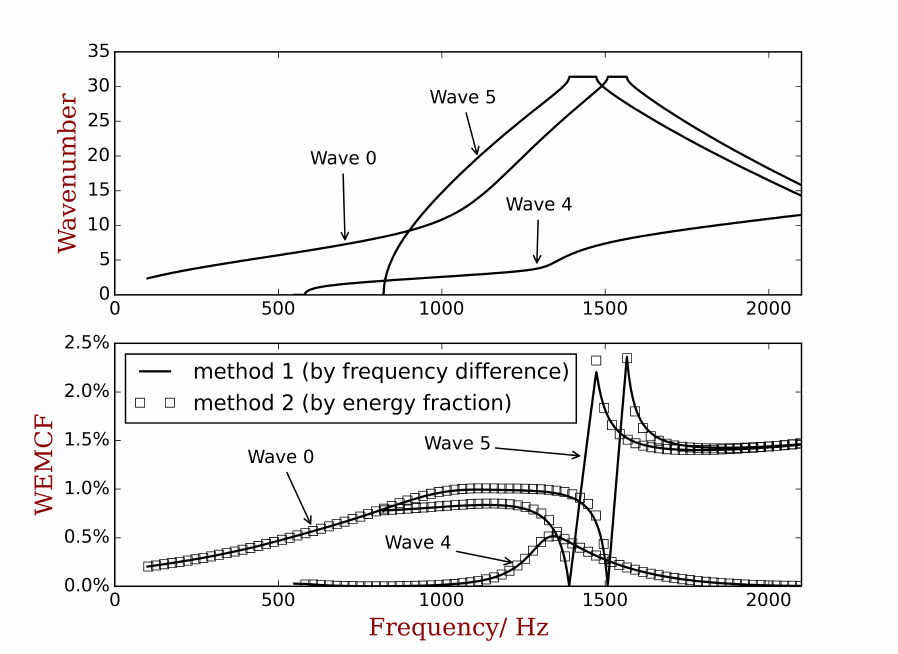
Figure 12. The comparison of WEMCF calculated by the frequency formula K 2 K 2 . Waves 0, 4 and 5 are selected from the full dispersion curves in Figure 11b. The K 2 1f by the reduced wave shapes as recommended in the last